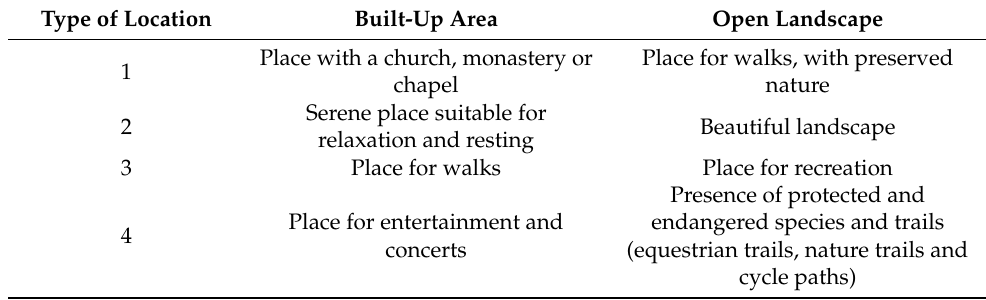
Figure 3. Overview of localities recorded in online data collection system within the South Moravia region. Table 2. Reason for preference: valuable locations—evaluated by all respondents.